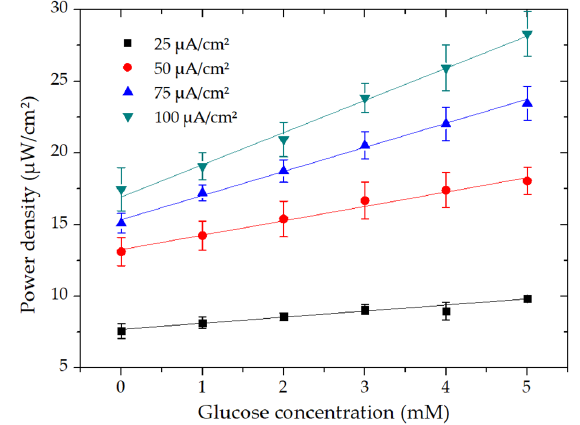
Figure 4. Evaluation of the calibration curves’ sensitivity of the microfluidic EBFC with the addition of glucose concentration concerning different current densities.